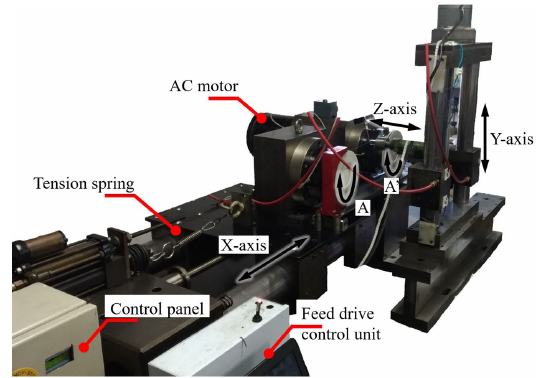
Figure 2. Endless wire saw test rig.